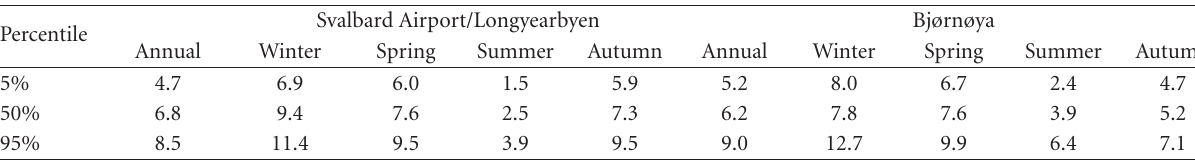
Table 6: Projected changes in 5-, 50-, and 95-percentile annual and seasonal temperatures ( ◦ C) from 1961–90 to 2071–2100 for Svalbard Airport and